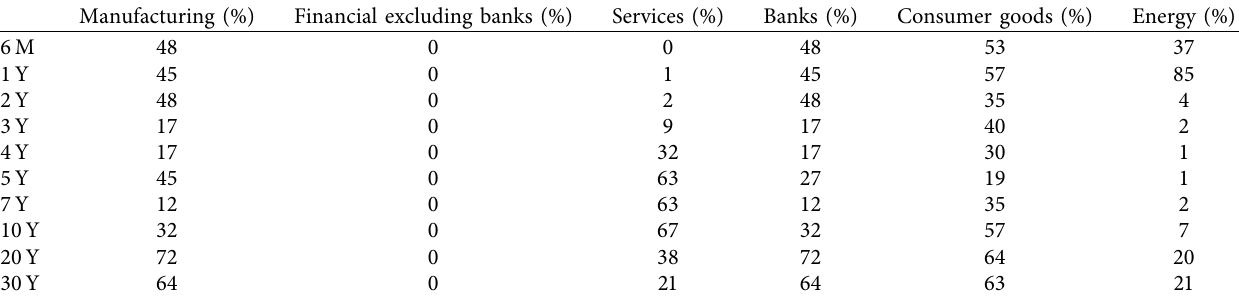
Table 2: p -values from the Chow test for all sectors,